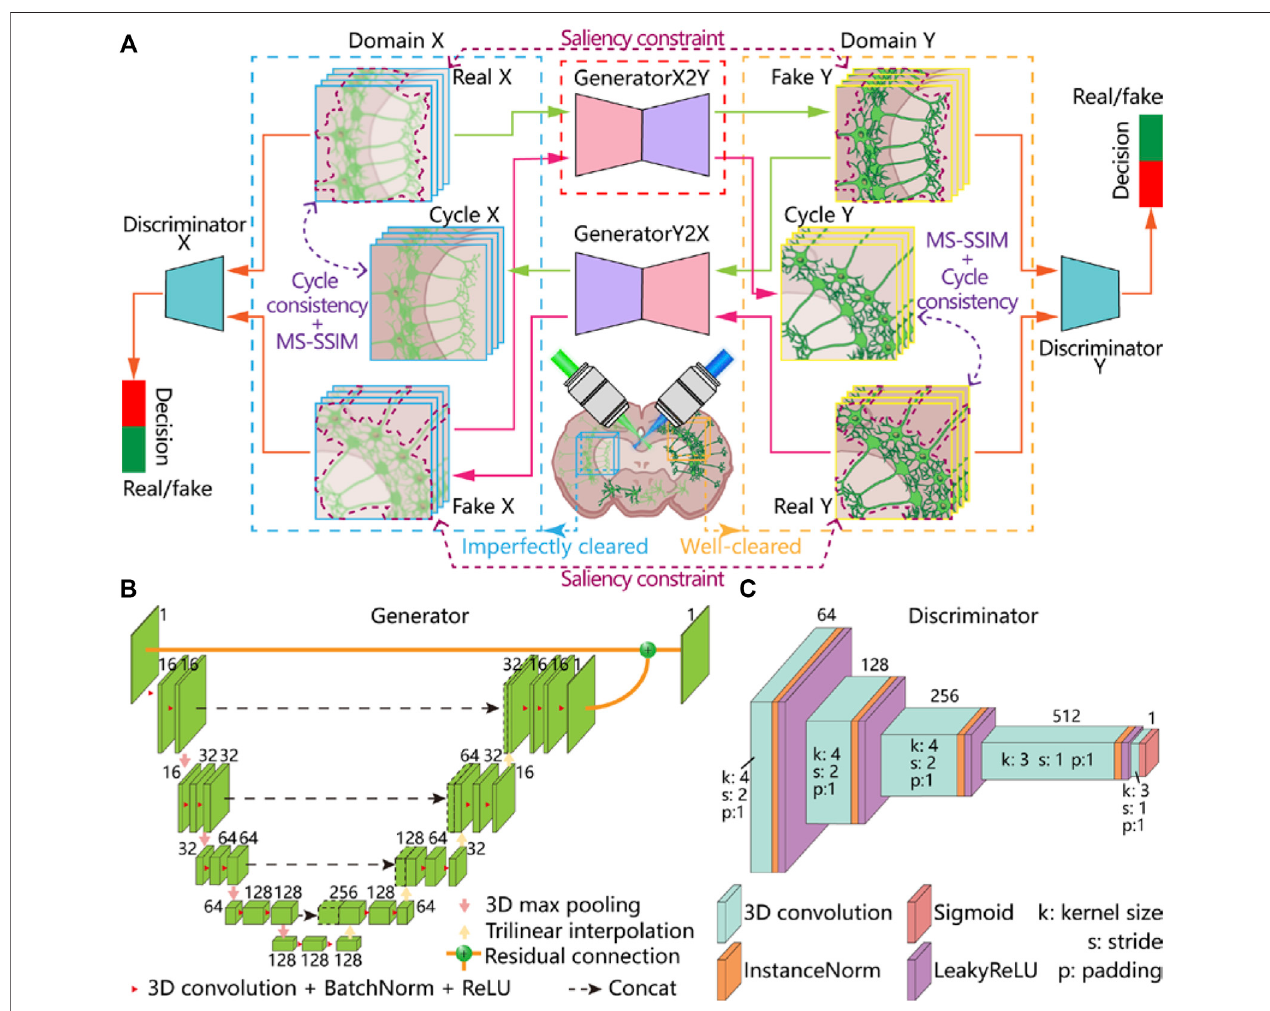
FIGURE1| Frameworkofvirtualopticalclearingmethodand3D-VoCycleGANarchitecture. (A) Theframeworkandwork fl owofourvirtualopticalclearingmethod. The 3D-VoCycleGAN consists of two generators and two discriminations (B) The network structure of generators. 3D ResUNet was used to build the two generators in our network (C) The network structure of discriminators. 3D PatchGAN was used to build the two discriminators in our network.